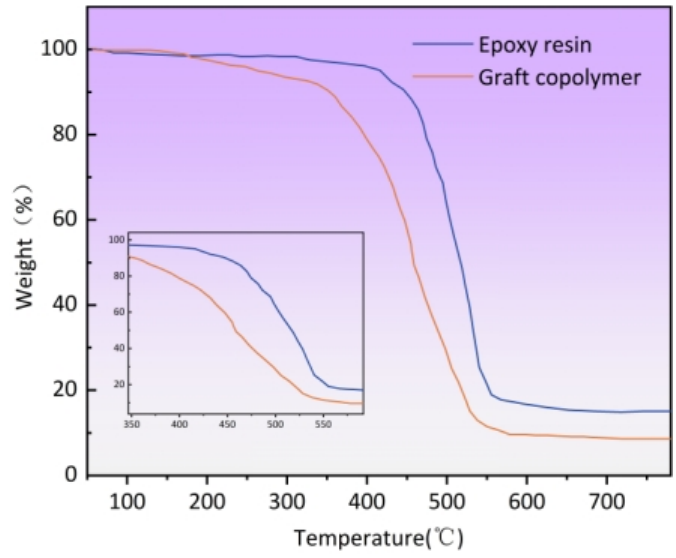
Figure 10. TGA curves of epoxy resin and graft copolymer.